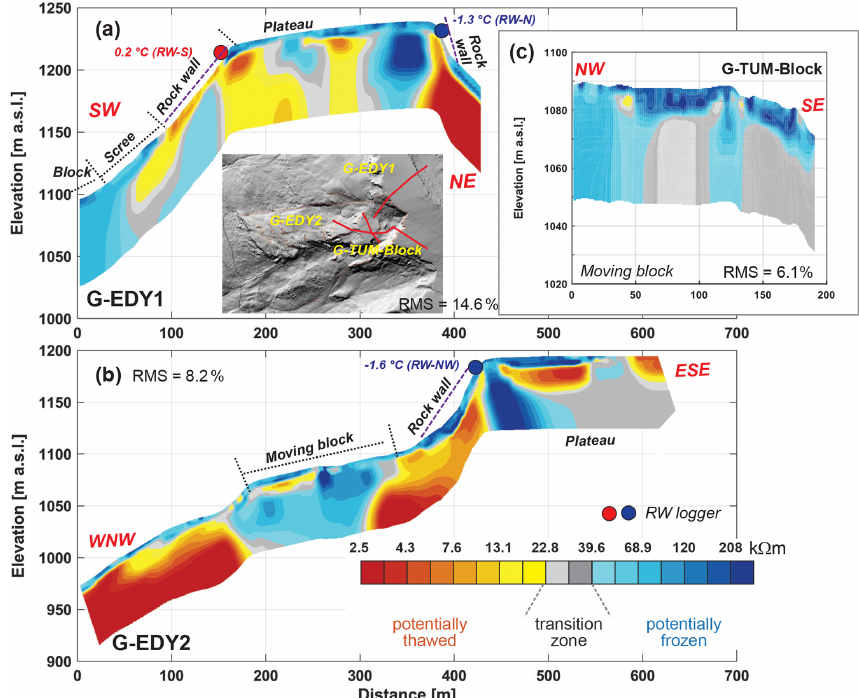
Figure 10. ERT surveys over the back scarp at Gámanjunni-3: (a) G-EDY1, which is oriented over the exposed part of the slip surface. While the rock wall shows low resistivity, there is a clear transition towards the scree and the moving block with considerably higher resistivity. (b) G-EDY2, which is placed over the north-western exposed part of the rock wall. There are significantly higher resistivities in both the rock wall and plateau, illustrating that this side is more influenced by the cooler rock wall. For both profiles, the locations of the rock wall loggers are indicated as circles. (c) G-TUM block oriented NW to SE over the moving block below the slip face. The resistivity is relatively high in relation to the plateau and below the